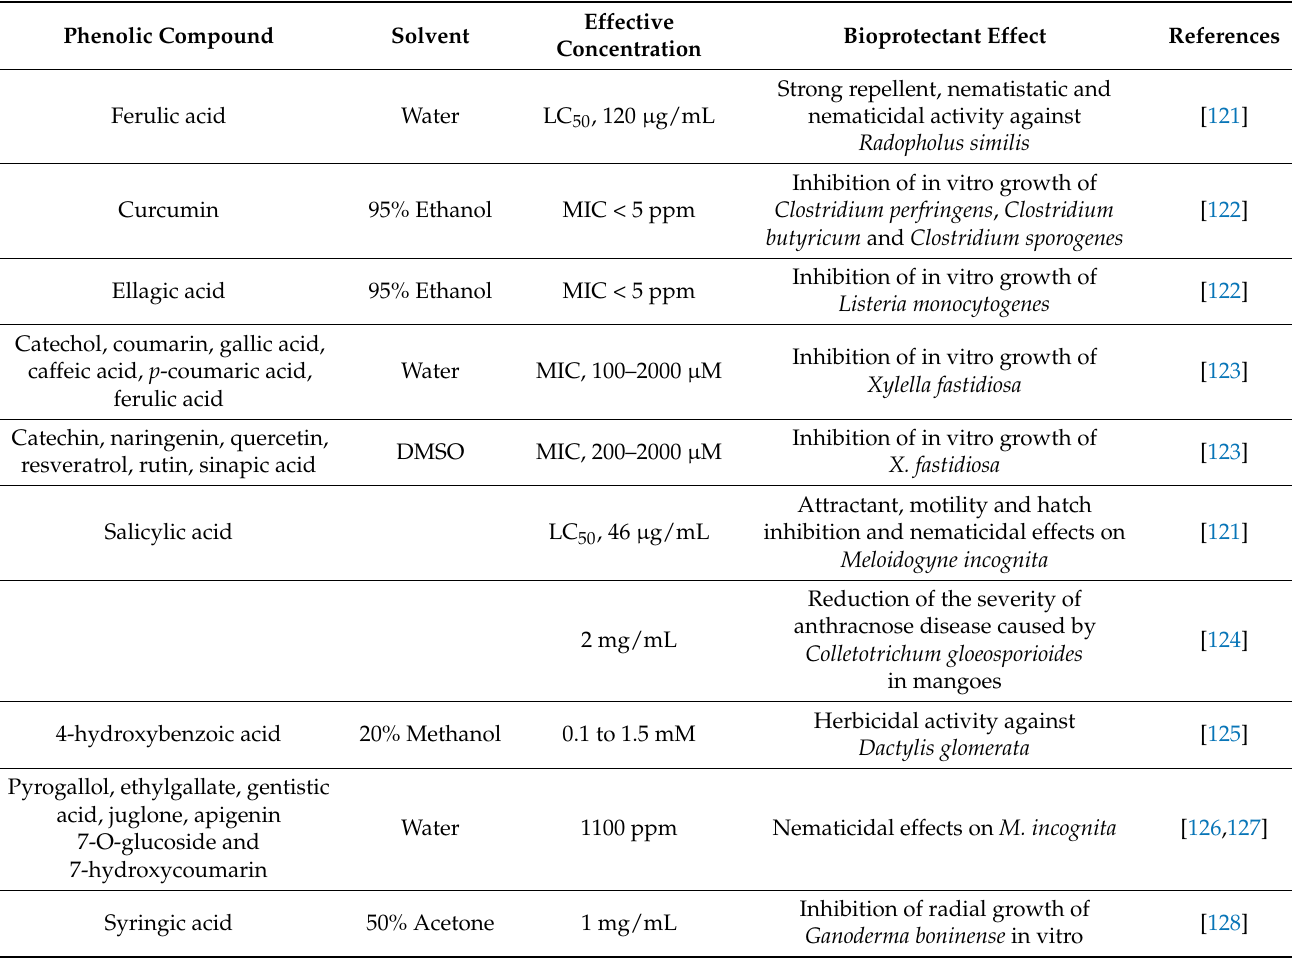
Table 4. Selected phenolic compounds with bioprotectant